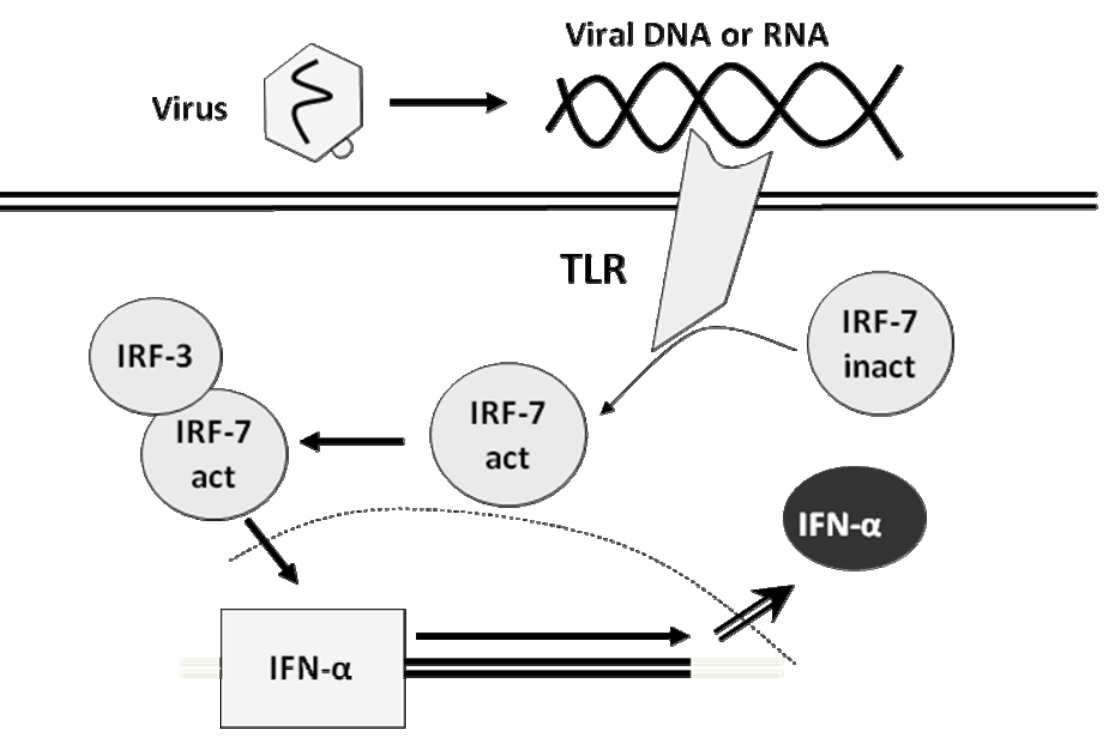
Figure 3. Simplified mechanism of regulation of the induction of the interferon genes in dendritic cells. IRF , interferon regulatory factor. Ovals represent proteins, squares represent